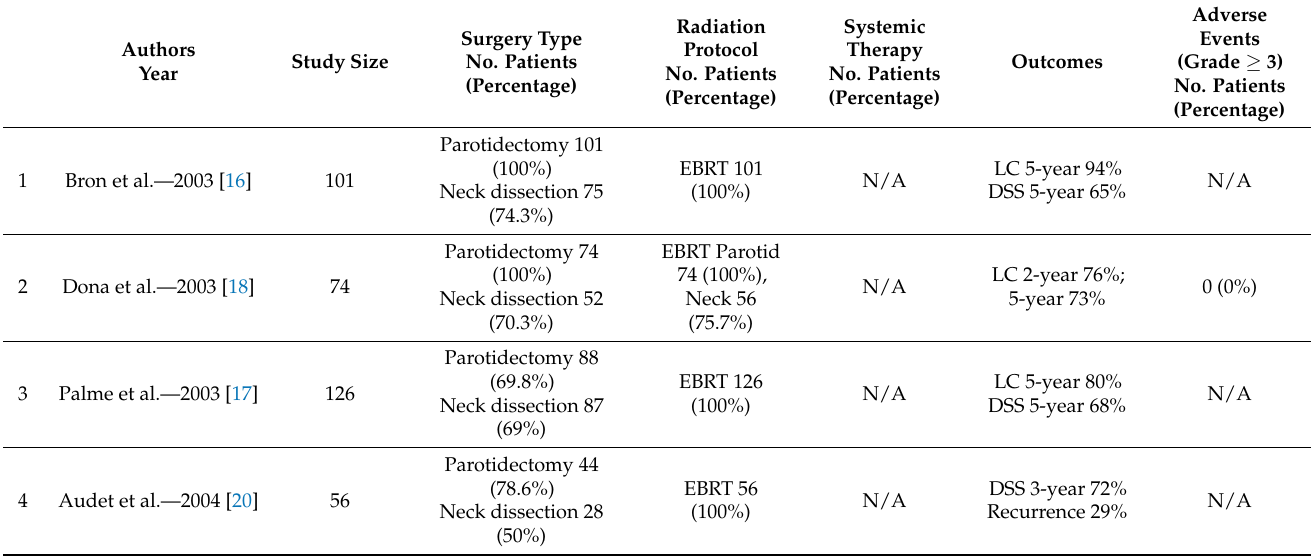
Table 1. Overview of studies including patients with operable locally advanced cutaneous squamous cell